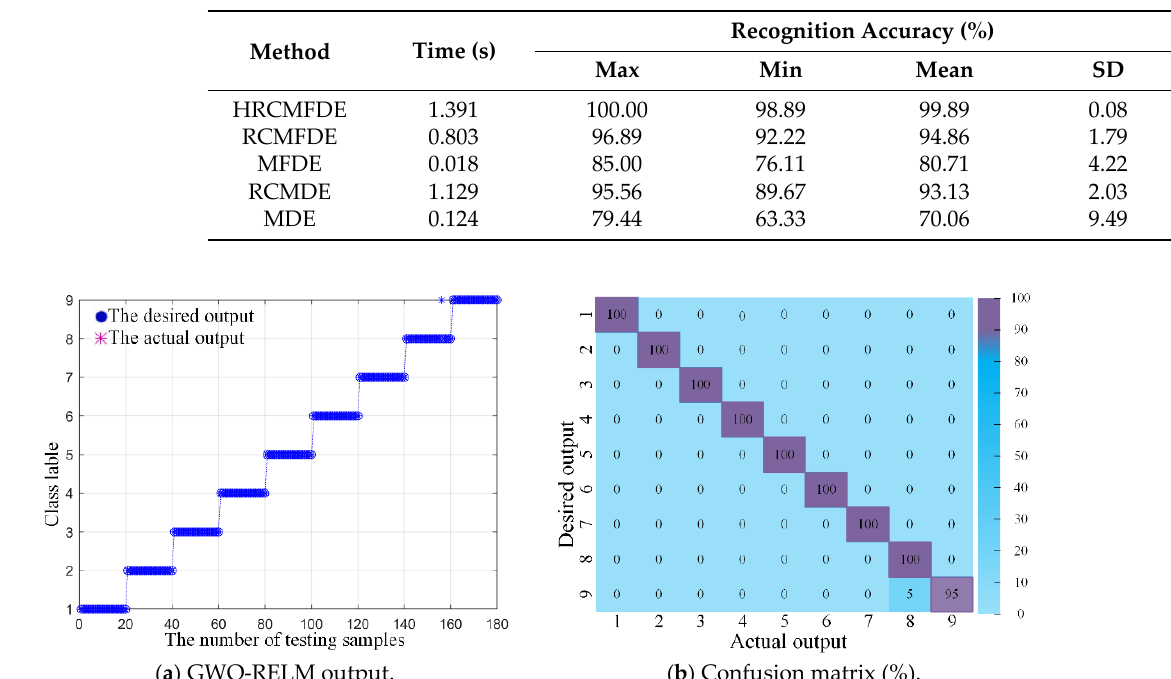
Table 13. The performance comparison between different methods.